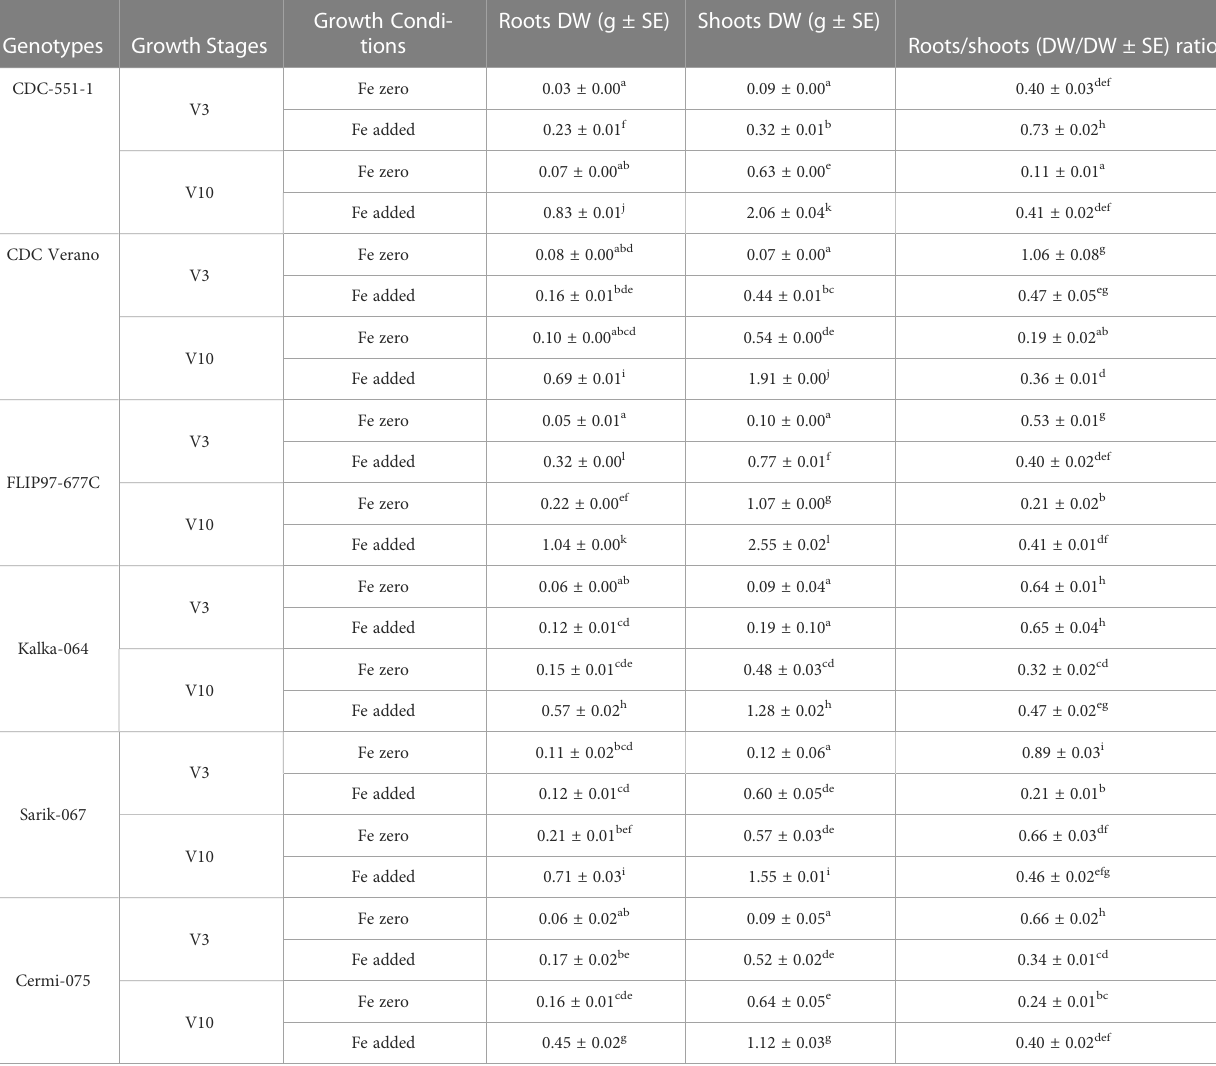
TABLE 3 Root to shoot (dry weight/dry weight) ratio of six chickpea genotypes under Fe zero and Fe added conditions at V3 and V10 growth stages.